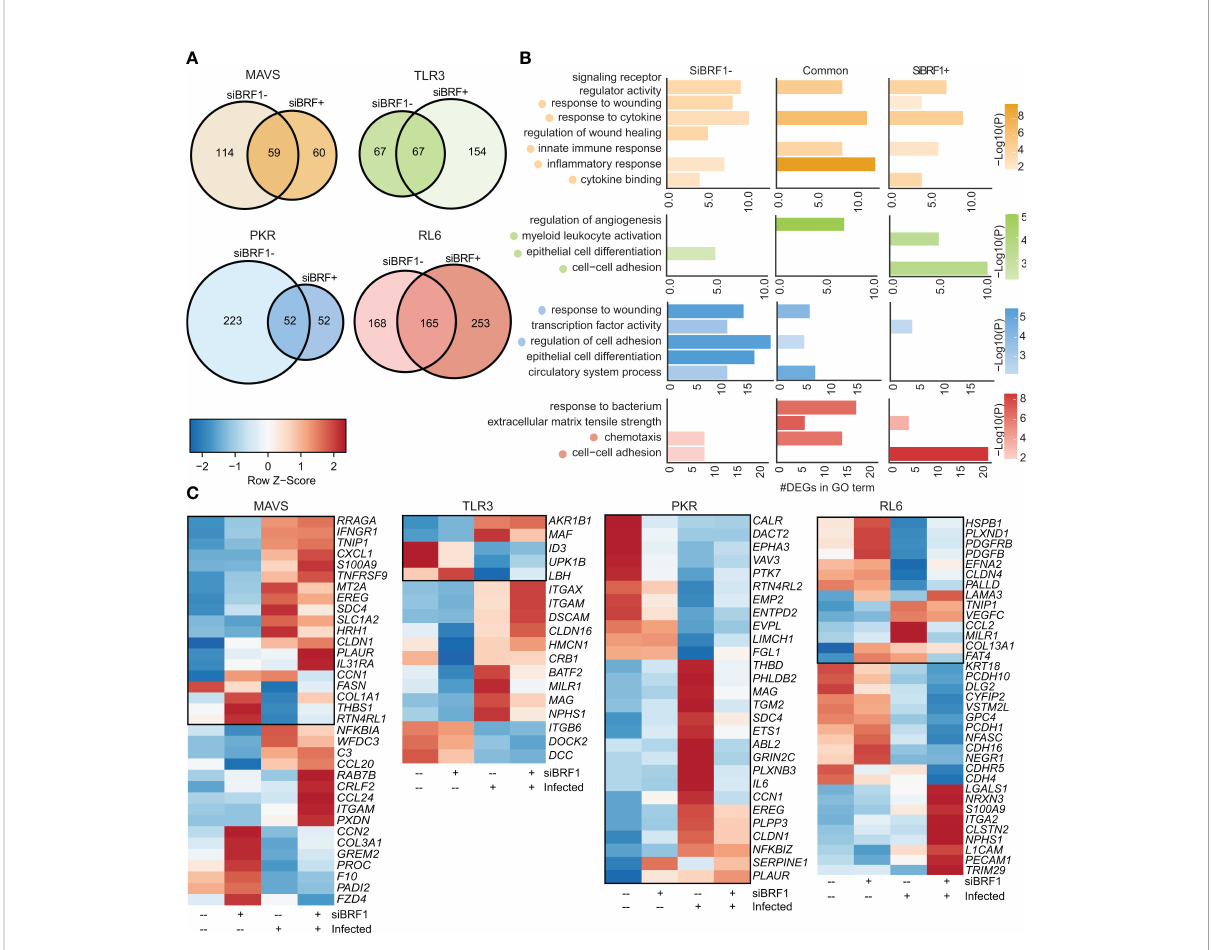
FIGURE 3 BRF1 silencing modulates antiviral transcriptional response. (A) Venn diagram of DEGs identi fi ed in siBRF1- infected vs noninfected cell lines relative to siBRF1+ counterparts. (B) Bar graph depicting functional enrichment of DEGs that are unique to siBRF1-, unique to siBRF1+, or common to all KO cell lines. Horizontal bars represent the number of DEGs enriching to each GO term. Colors are based on the GO terms with the lowest and highest – log(p-value) values. (C) Clustered heatmap comparing TPMs of DEGs mapping to the selected GO terms in (A) . Color range is based on scaled and centered TPM values. Boxed genes indicate differential expression in the siBRF1-